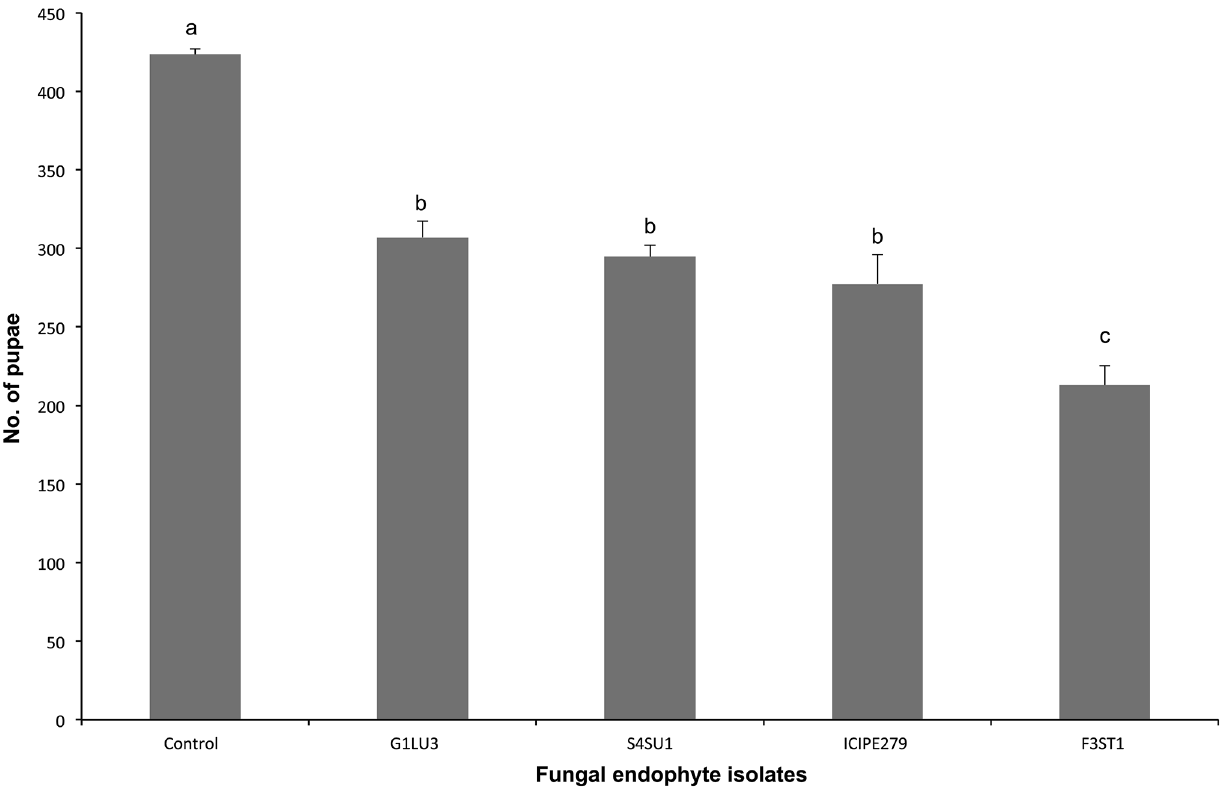
Figure 3. Effect of Viciafaba plants endophytically-colonized by different fungal isolates of Beauveriabassiana (S4SU1, G1LU3 and ICIPE 279) and Hypocrealixii (F3ST1) and infested with 2 nd and 3 rd instar larvae of Liriomyzahuidobrensis on the number of pupae produced after adult parents Diglyphusisaea exposure. Bars denote means 6 one standard error at 95% CI (p=0.05).